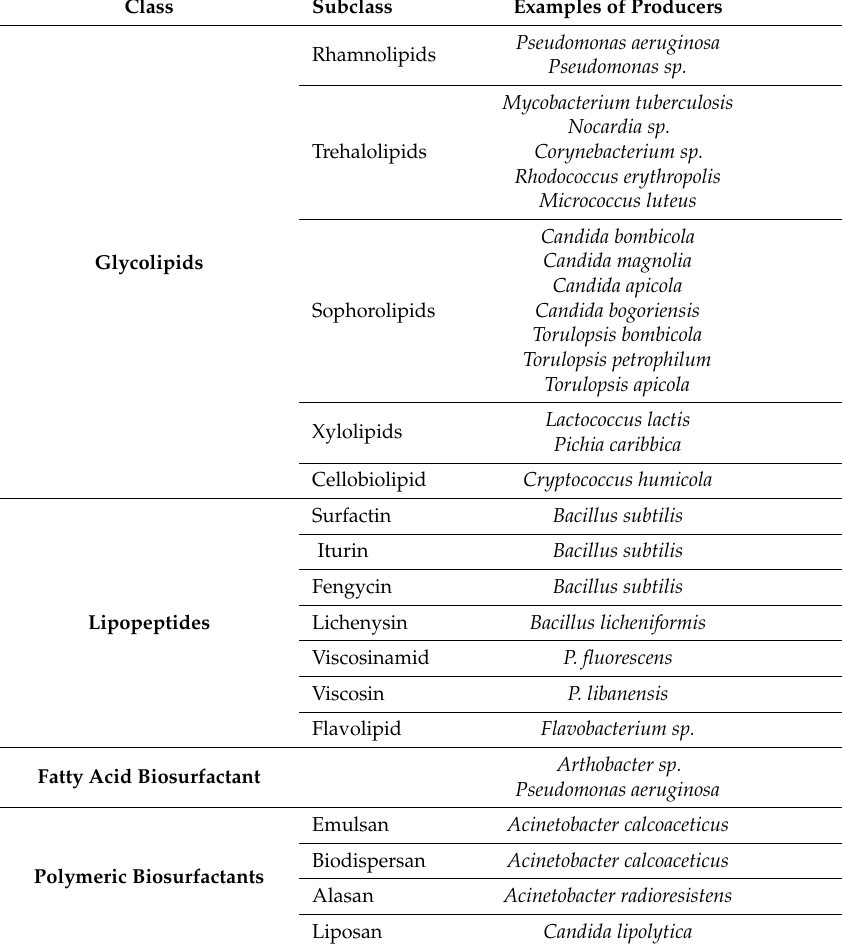
Table 1. Different groups of microbial biosurfactants